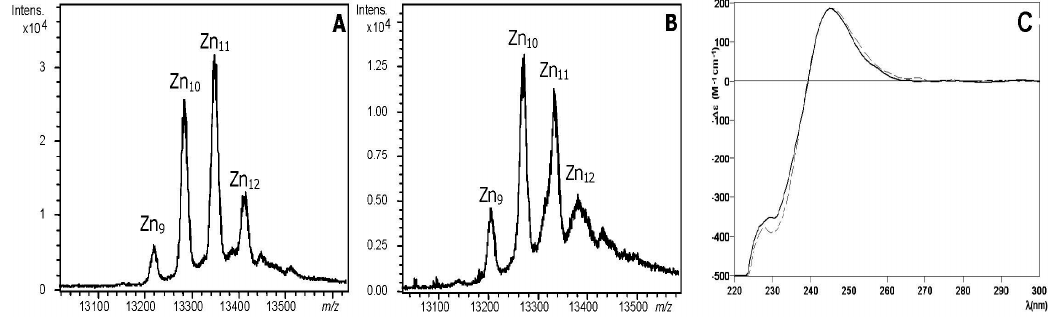
Figure 3. MS and circular dichroism (CD) spectra of Zn-BgMT: Deconvoluted ESI-MS spectra of the recombinant ( A ) Zn-BgwtMT and ( B ) Zn-BgKNMT, recorded at neutral (7.0) pH; ( C ) CD spectra of each Zn(II)-preparation: BgwtMT (solid line) and BgKNMT (dashed). Table 1. Analytical characterization of the recombinant Zn-, Cd- and Cu-preparations of BgwtMT and BgKNMT. All data for the copper supplemented cultures correspond to normal aeration conditions, since no complexes could be recovered from low aerated cultures. Abbreviations: MT: